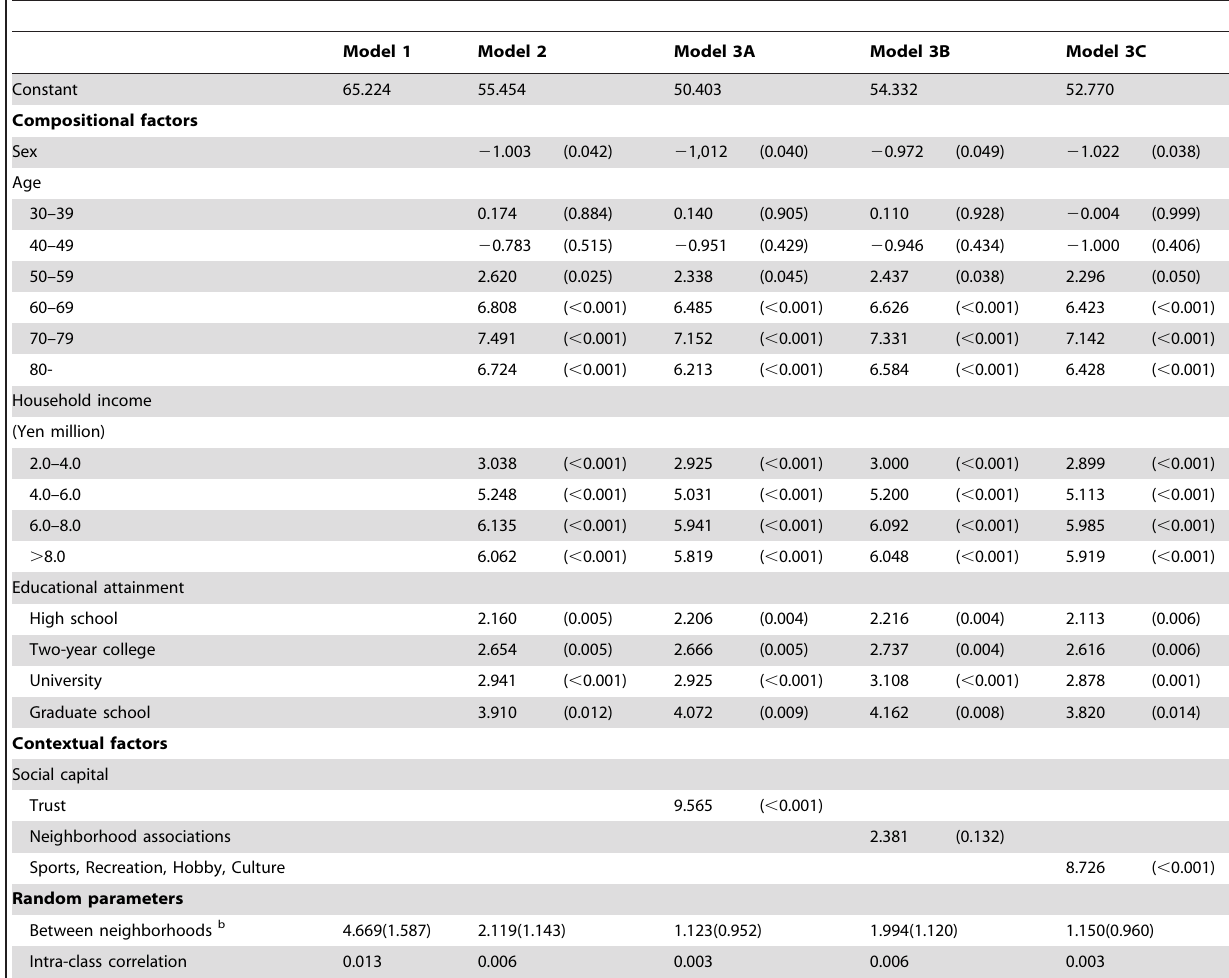
Table 2. Fixed and random part results for the multilevel analytical models.